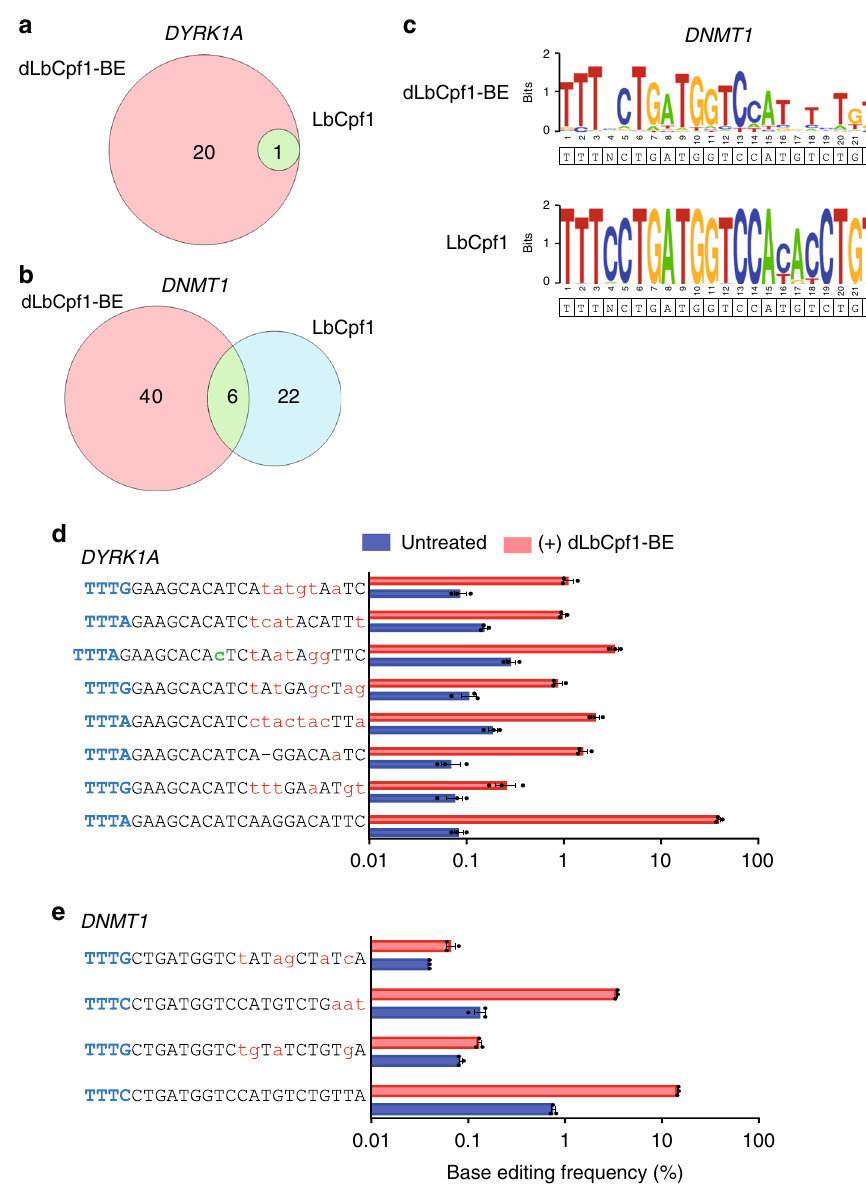
Fig. 3 Genome-wide off-target sites of dLbCpf1-BE revealed by Digenome-seq and targeted deep sequencing. a , b Venn diagrams showing the number of in vitro cleavage sites in the human genome produced by dLbCpf1-BE or LbCpf1 nuclease targeting the DYRK1A ( a ) and DNMT1 ( b ) sites that were identi fi ed by Digenome-seq. c Sequence logos were generated for DNA sequences captured by dLbCpf1-BE- and LbCpf1-mediated Digenome-seq using WebLogo. d , e Base editing frequencies of dLbCpf1-BE at in vitro cleavage sites, identi fi ed by dLbCpf1-BE-mediated Digenome-seq, were measured using targeted deep sequencing of genomic DNA from HEK293T cells. Mismatched bases and PAM sequences are shown in red and blue, respectively. An RNA bulge is represented as a dash and a DNA bulge is shown in green. Data are shown as mean ± s.e.m. from three biologically independent